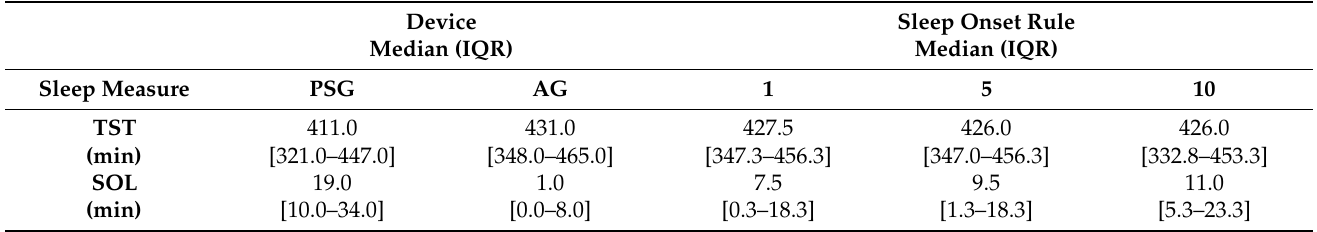
Table 1. Descriptive statistics of sleep measures for device and sleep onset